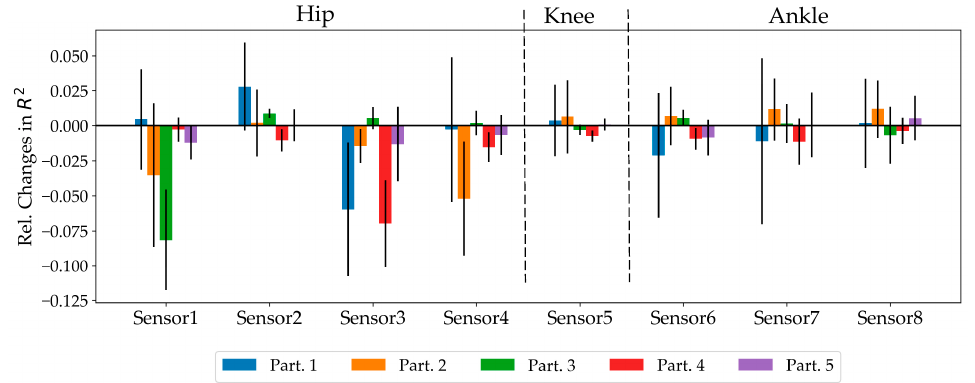
Figure 5. Relative changes in the coefficient of determination by excluding all features from a sensor for each participant. Table 3. The coe ffi cient of determination and root mean squared value of predicted values while using a single joint sensor with standard